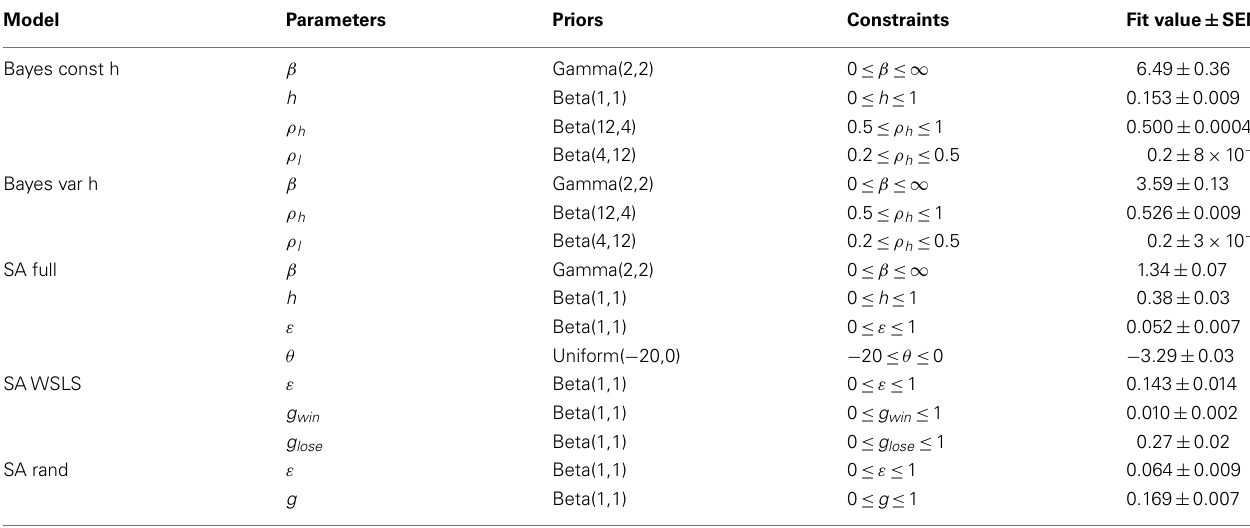
Table 1 | List of parameters with accompanying priors and constraints used in the model-based analysis.